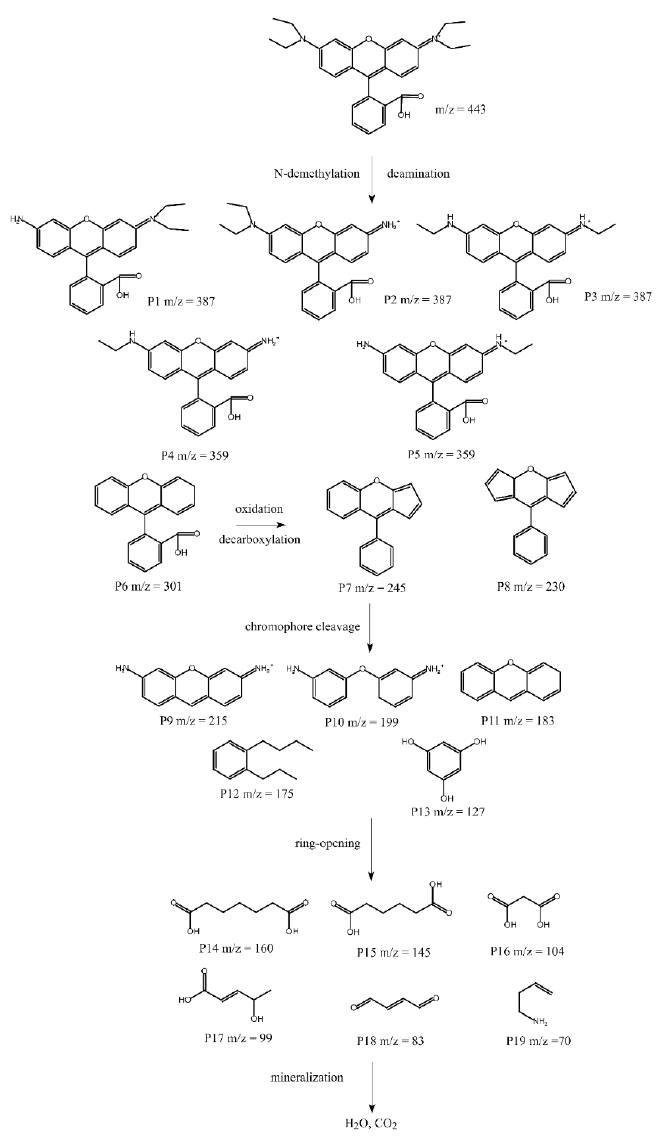
Figure 9. Proposed degradation pathway of RhB in the CM/g-C 3 N 4 /PMS system.